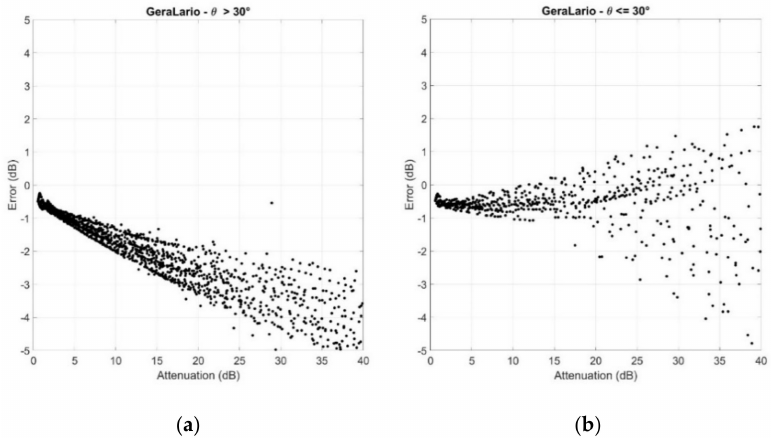
Figure A1. Scatter plots of the error ε = A SST , glo − A SST versus A SST : ( a ) θ > 30 ◦ ; ( b ) θ ≤ 30 ◦ . Gera Lario.